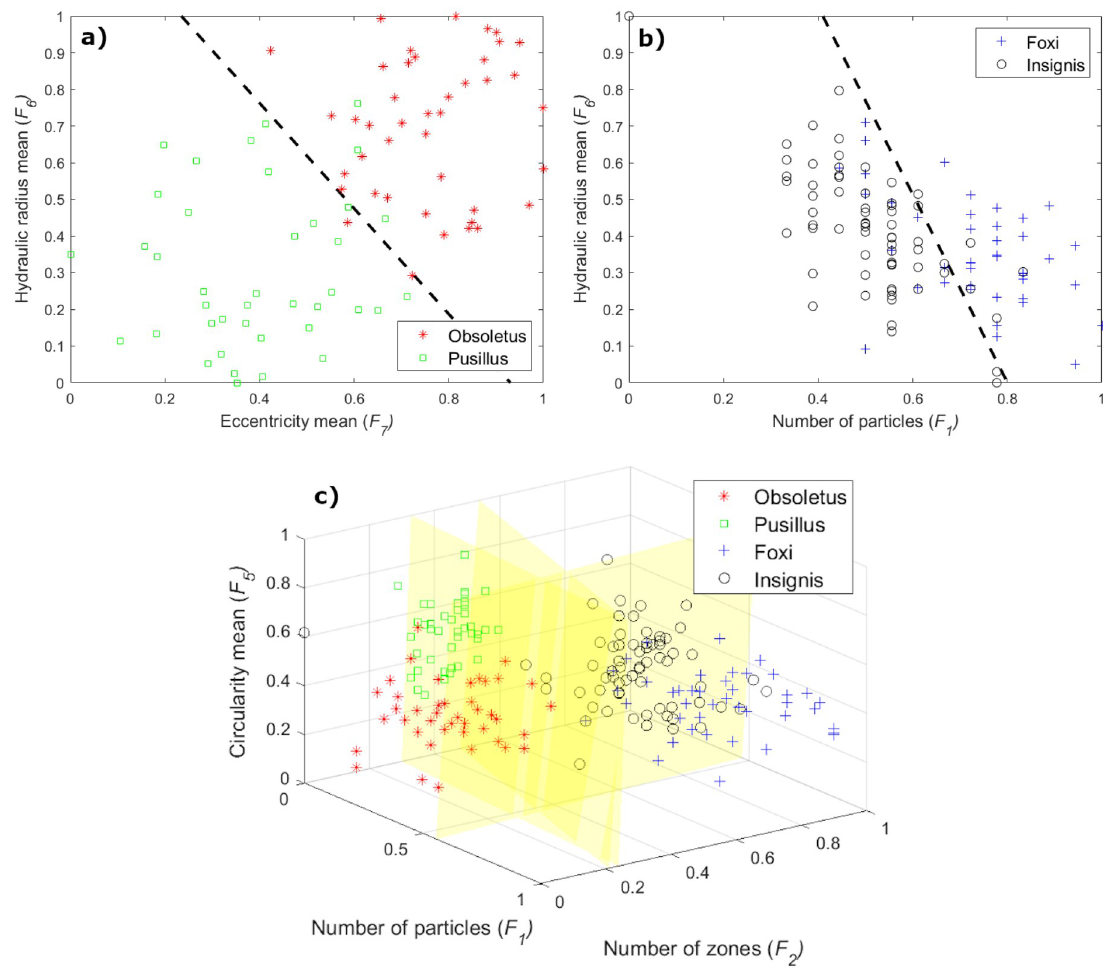
Fig 10. Biting midges species separation according to the LDA classifier using the optimal subset of features in (a) fDataset, (b) eDataset, and (c) both datasets together.